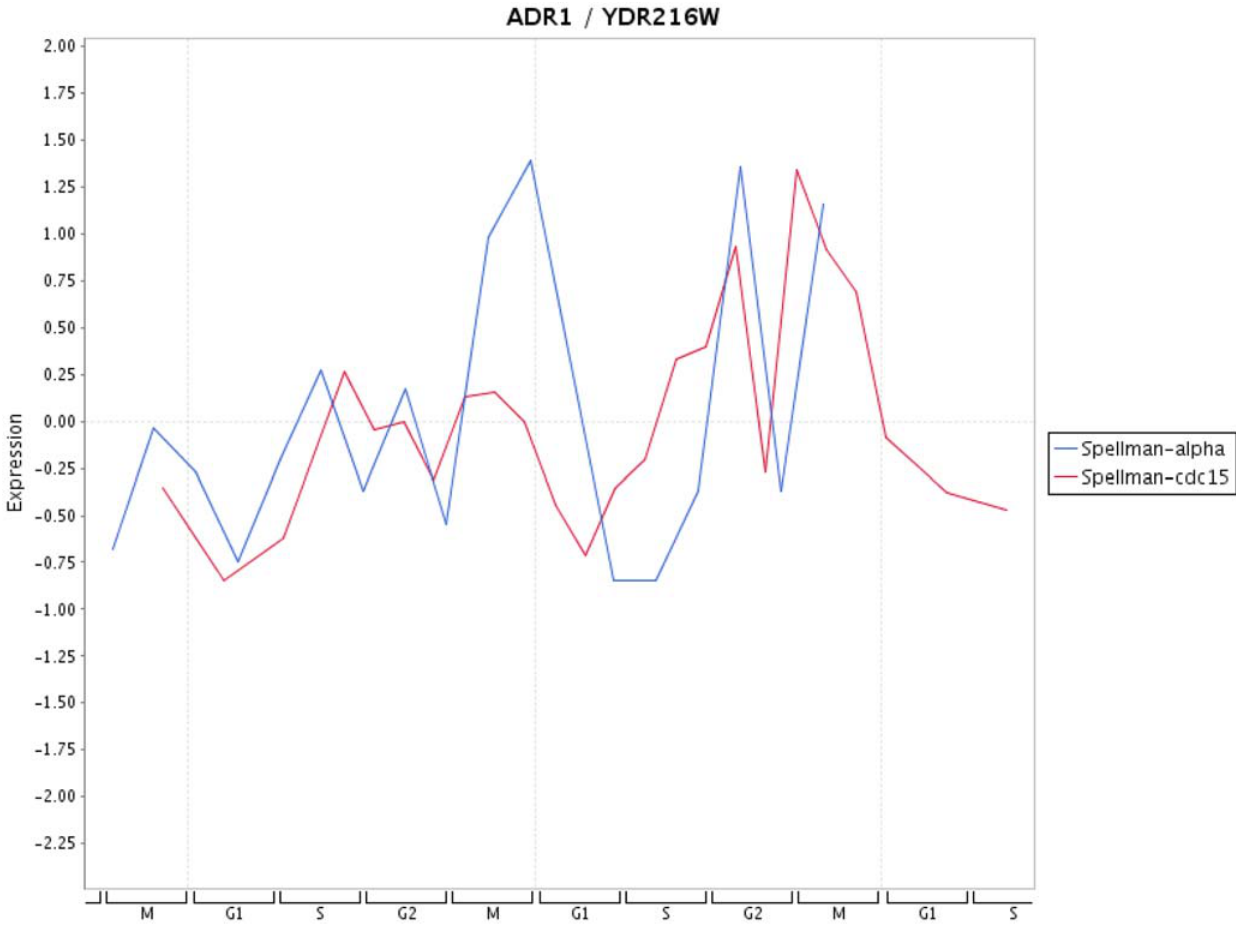
Figure 13. Expression profile for ADR1 for time series data from S PELLMAN et al. [ 32 ] .